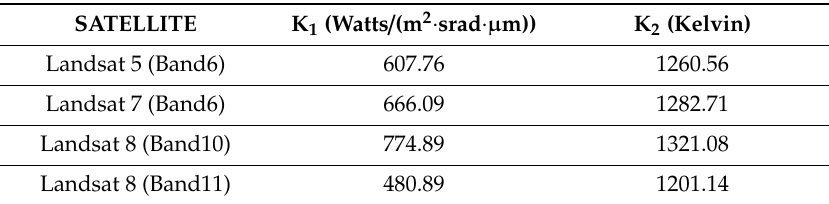
Table A2. Thermal band calibration constants for landsat satellites.